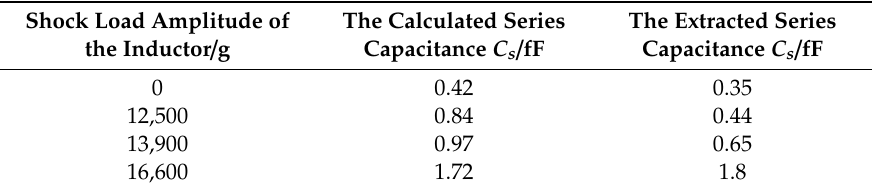
Table 2. The series capacitance C s of the inductors.